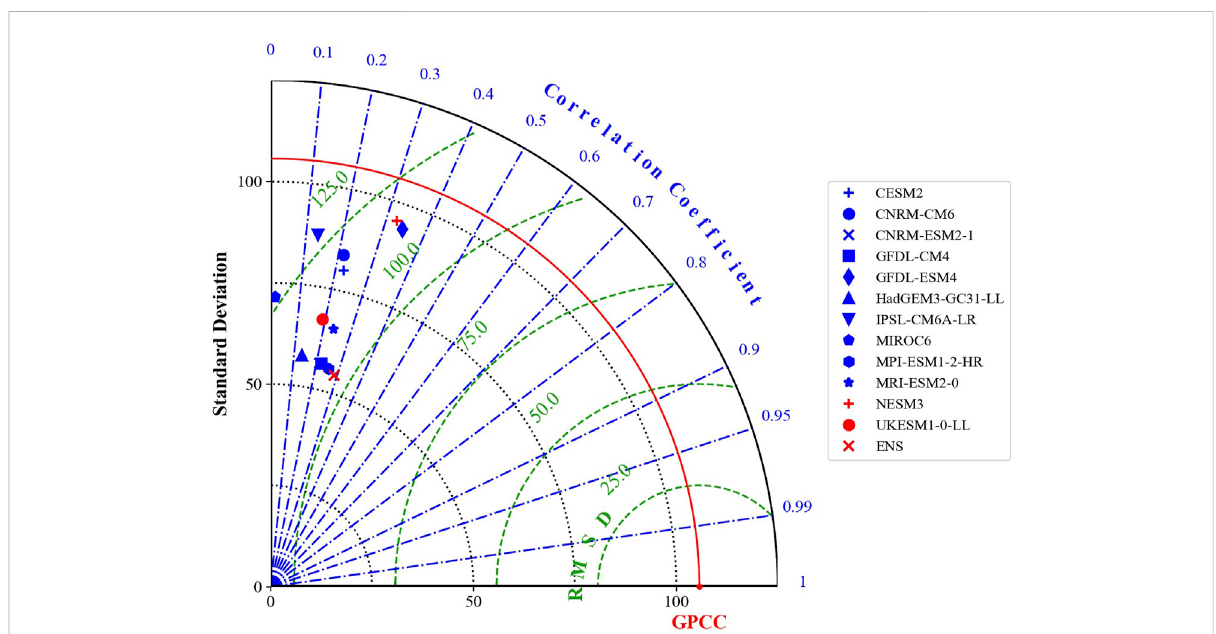
FIGURE 6 Taylor diagram comparing annual (January-December) PRE observation (GPCC) with models (CMIP6).